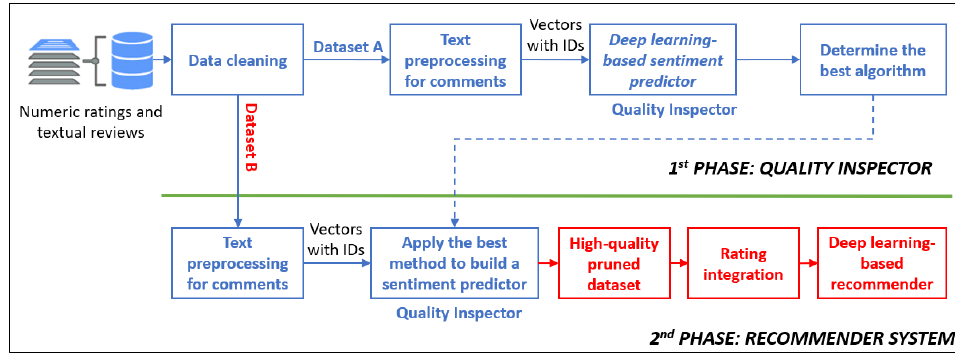
Figure 1. Overall view of the proposed framework.